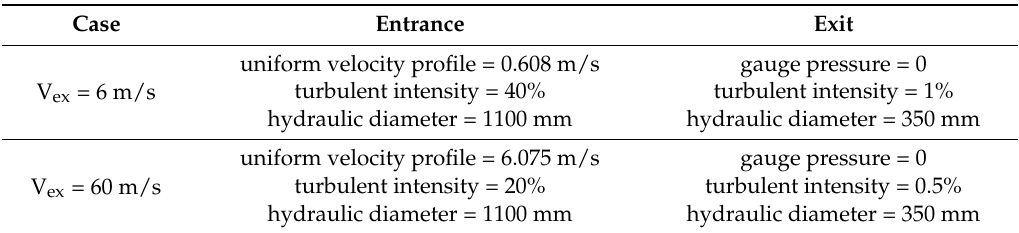
Table 2. Designations of boundary